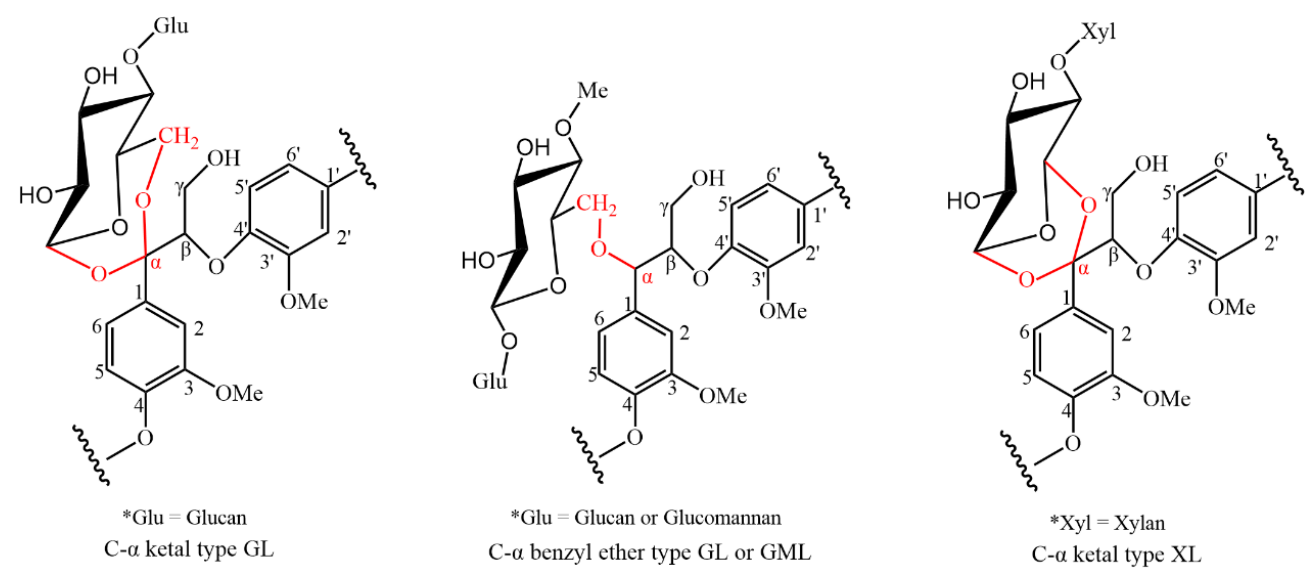
Figure 10. LCC linkages in ginkgo CW-DHP.